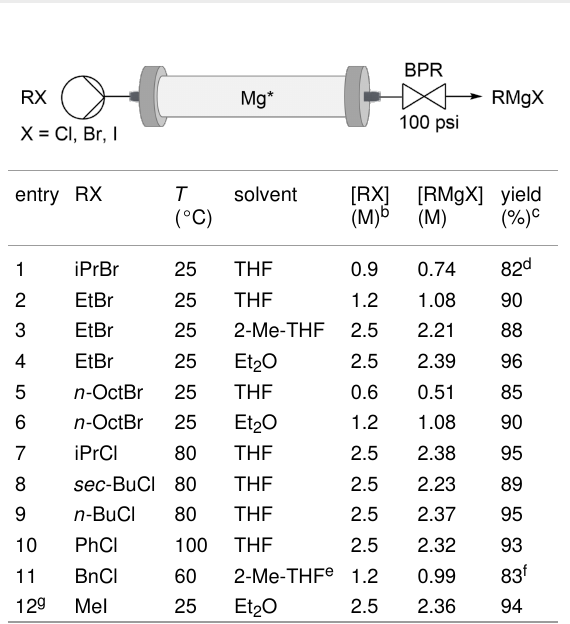
Table 1: Reaction of organic halides in a packed-bed column of acti- vated magnesium. Scope of Grignard reagents prepared under flow conditions. a